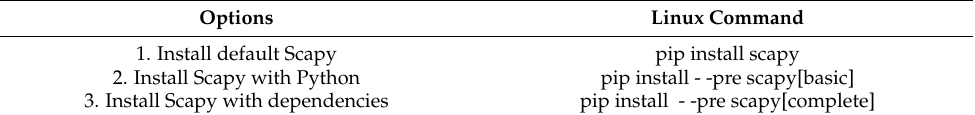
Table 4. Scapy installation commands